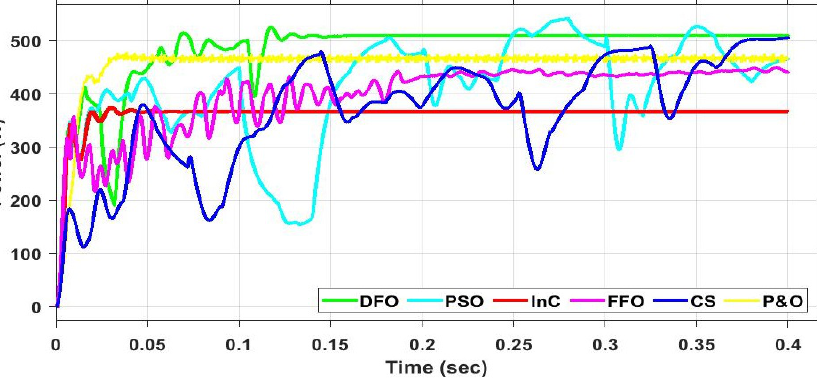
Figure 25. PS1 power comparison between all algorithms for MLPE Distributed PV